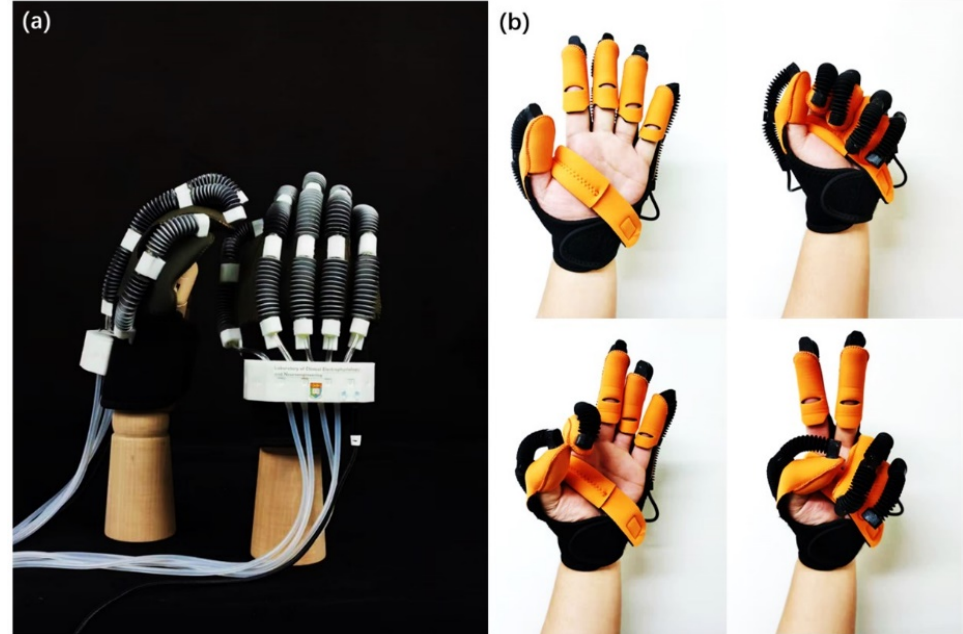
Figure 9. ( a ) Soft robotic exoskeleton gloves actuated by GBBAs (GBBAs Gloves); ( b ) four representative gestures realized through the five-channel control system.